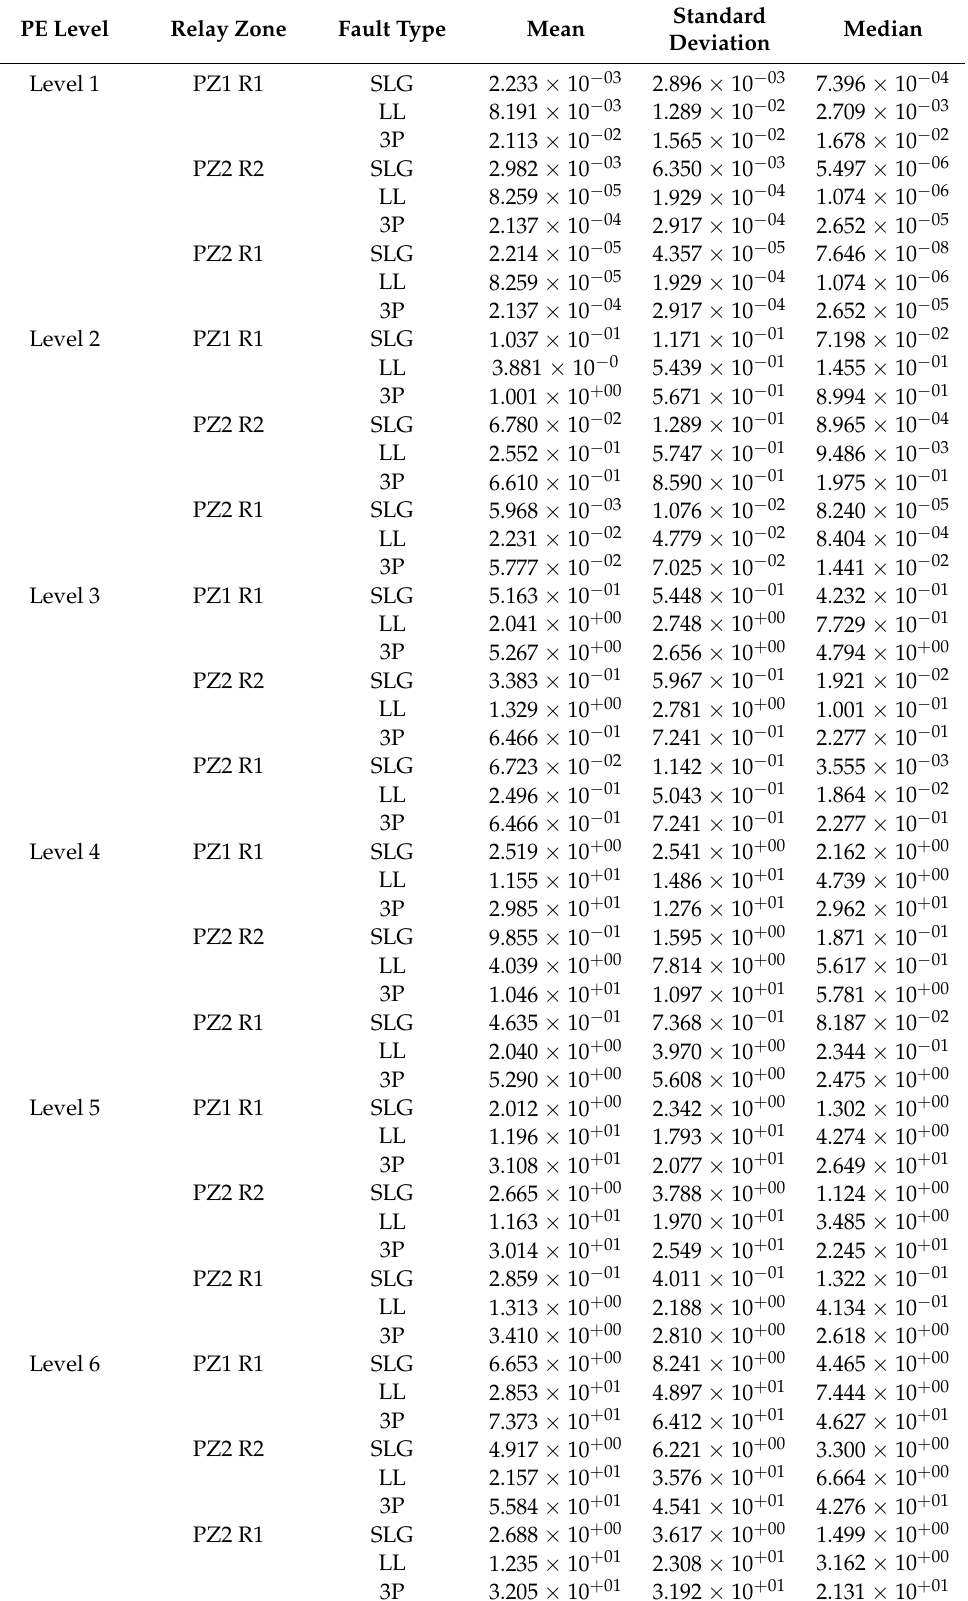
Table A7. PE values aerial 2